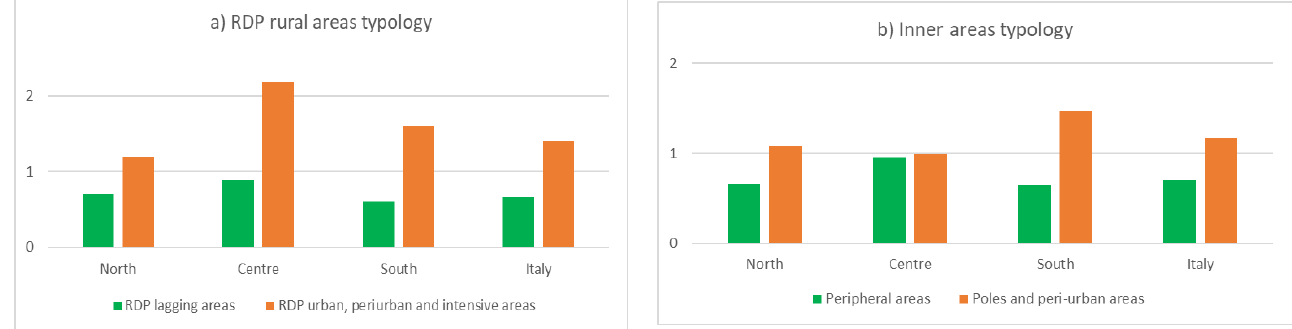
Figure 8. “Corrected” committed expenditures allocated by types of areas according to the two in- stitutional typologies. Definition ( a ): RDP rural areas; definition ( b ): IAS rural areas. Source: authors’ elaborations from the data base of funded investment projects.